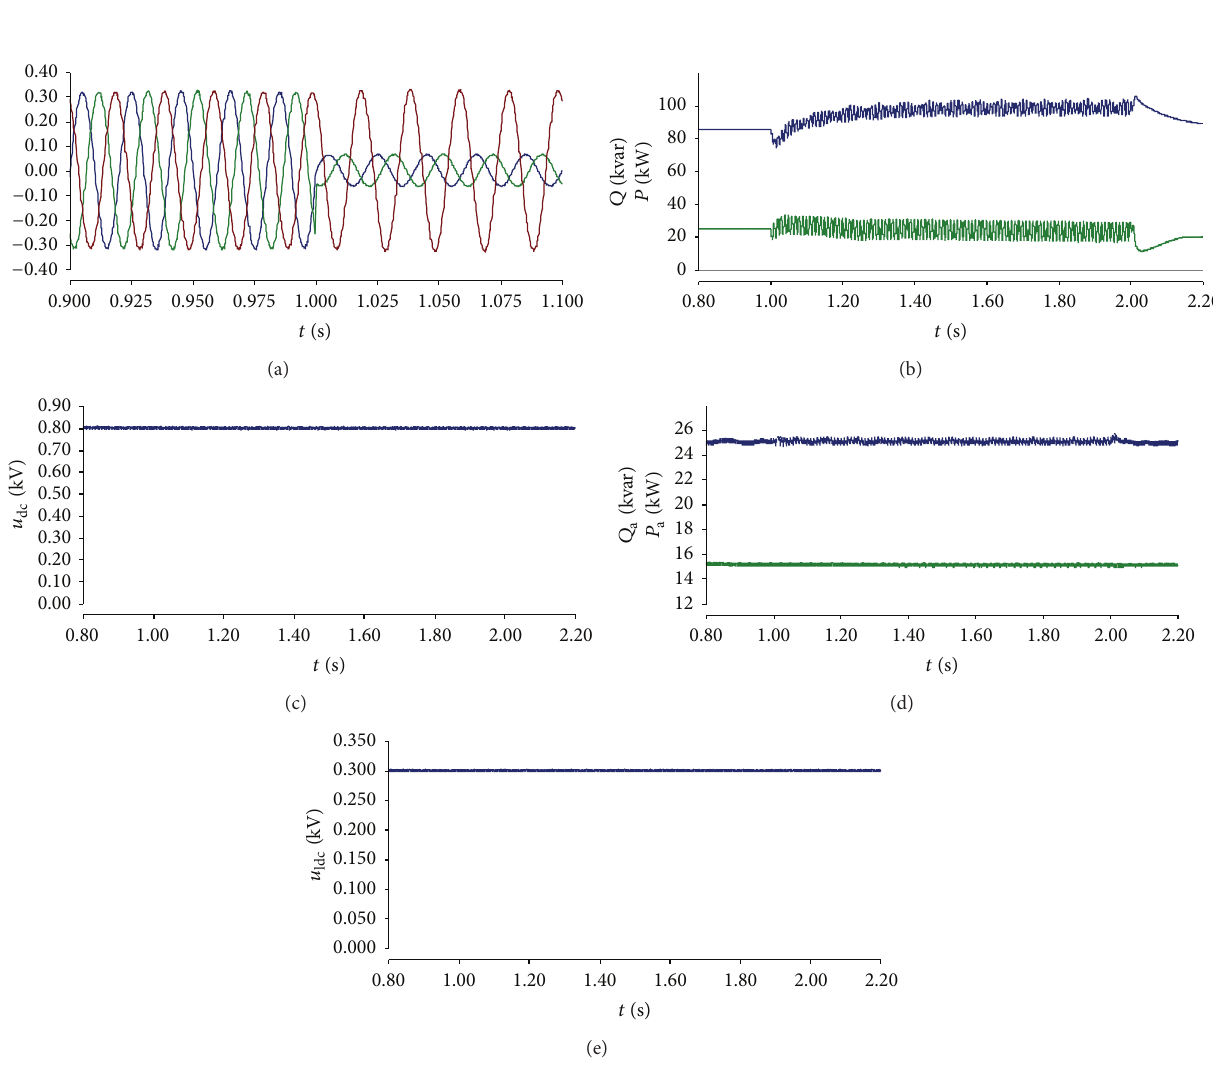
Figure 8: (a) Microgrid main feeder voltage waveform under two-phase ground fault in distribution network. (b) Microgrid exporting power waveform under two-phase ground fault in distribution network. (c) DC bus voltage waveform of sub-microgrid A under two-phase ground fault in distribution network. (d) AC load power waveform of sub-microgrid A under two-phase ground fault in distribution network. (e) DC load voltage waveform of sub-microgrid A under two-phase ground fault in distribution